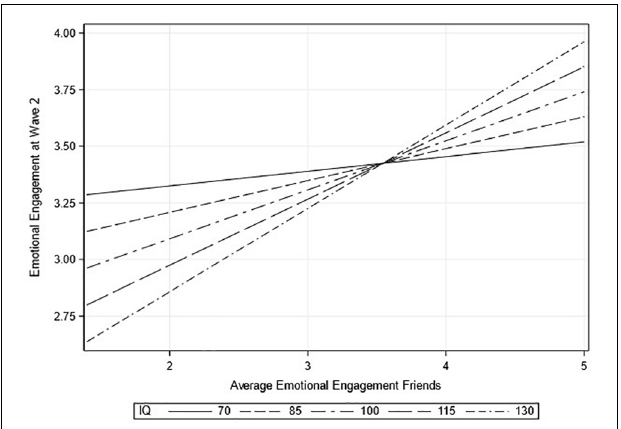
significant in the sensitivity analysis. Treating IQ as a continuous variable did result in a significant and negative effect of IQ on behavioral disengagement ( b = − 0.04, p = 0.018) as was found in the main analysis. Lastly, a significant interaction between IQ and the average emotional engagement of friends was found. A graphical representation of this interaction can be found in Figure 1 . This finding indicates a stronger effect of the emotional engagement of friends for students with a higher IQ ( b = 0.04, p =